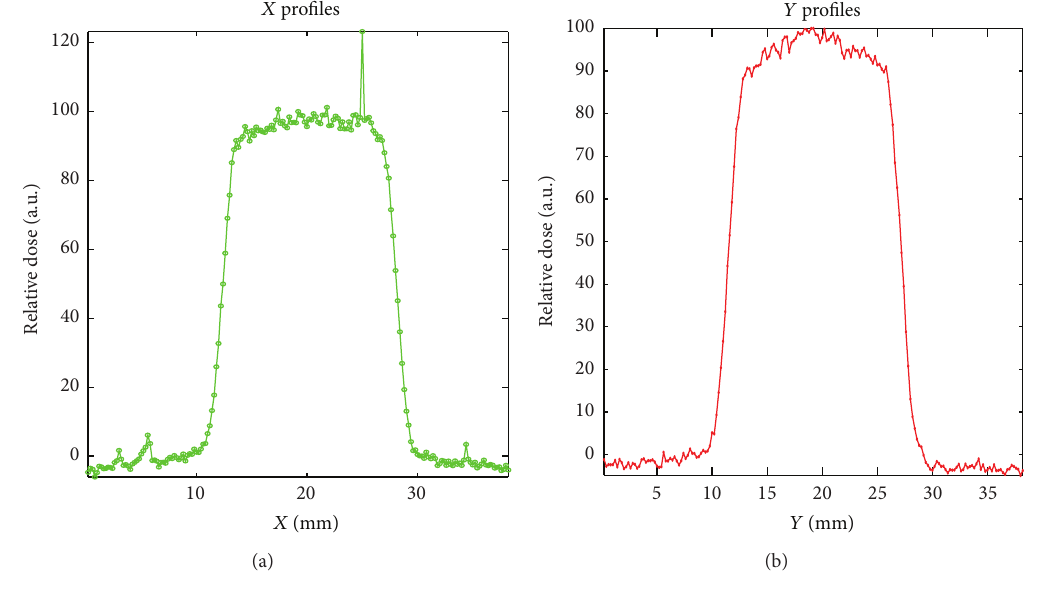
Figure 18: Beam profile characterization acquired with calibrated diodes.